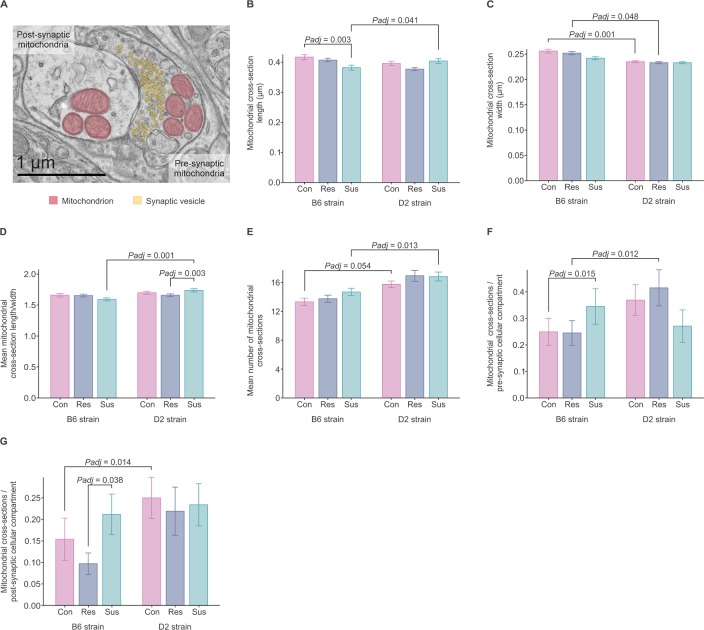
Chronic social defeat stress affects BNST mitochondrial morphology of B6 and D2 mice.(A) Transmission electron microscopy image showing pre- and post-synaptic neuronal compartments, mitochondria (red) and vesicles (yellow) located next to the synapse. (B-G) Graphs showing mean differences between B6 and D2 stress-susceptible, resilient and control mice in (B) maximum (length) and (C) minimum (width) diameters of mitochondrial cross-sections, (D) mean mitochondrial cross-section length/width ratio, i.e., maximum/minimum diameter (E) mean number of mitochondrial cross-sections (F-G) number of mitochondrial cross-sections per (F) pre-synaptic and (G) post-synaptic cellular compartment. P-values were adjusted for multiple testing with test-wise Bonferroni correction. Mean values ± S.E.M. B6: C57BL/6NCrl; Con: control; D2: DBA/2NCrl; Res: resilient; Sus: susceptible.